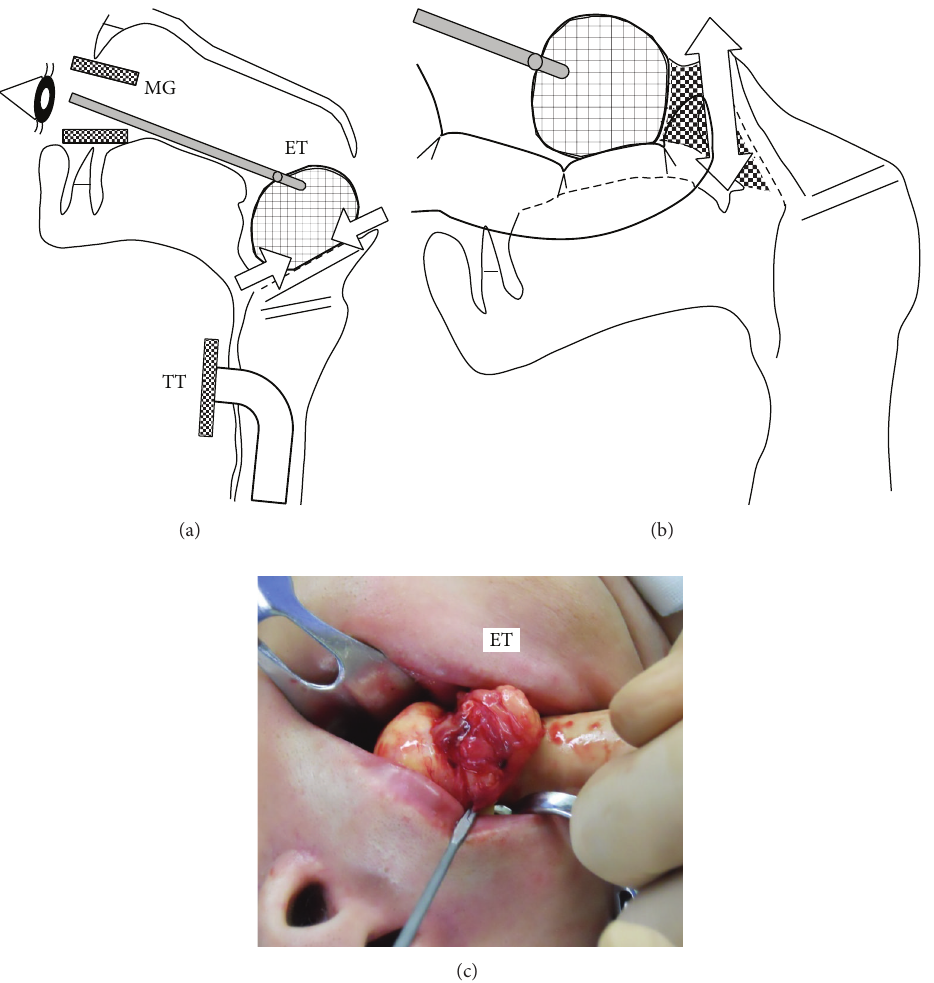
Figure 3: Illustrations and a photograph of transoral finger dissection. (a) After a tracheotomy and cessation of microscopic laryngeal surgery, the patient’s mouth was opened with a large mouth gag (MG). Under macroscopic observation while maintaining the airway with a tracheostomy tube (TT), the epiglottic tumor (ET) was pulled into the oral cavity by grasping its frontal wall with forceps. The root of the lipoma attached to the epiglottis was slightly incised using a scalpel (arrows). (b) Traction was placed on the lipoma while simultaneously elevating the epiglottis and larynx to generate a spatial gap between ET and epiglottic cartilage. ET was blindly separated from epiglottic cartilage using the surgeon’s index finger inserted into the gap. Because mucosal bundles covering ET converge to the lateral sides of the epiglottic attachment, they were cut using an electric knife (double-headed arrow). Consequently, ET was dissected en bloc. (c) ET was pulled out of the oral cavity and was manipulated using the surgeon’s index